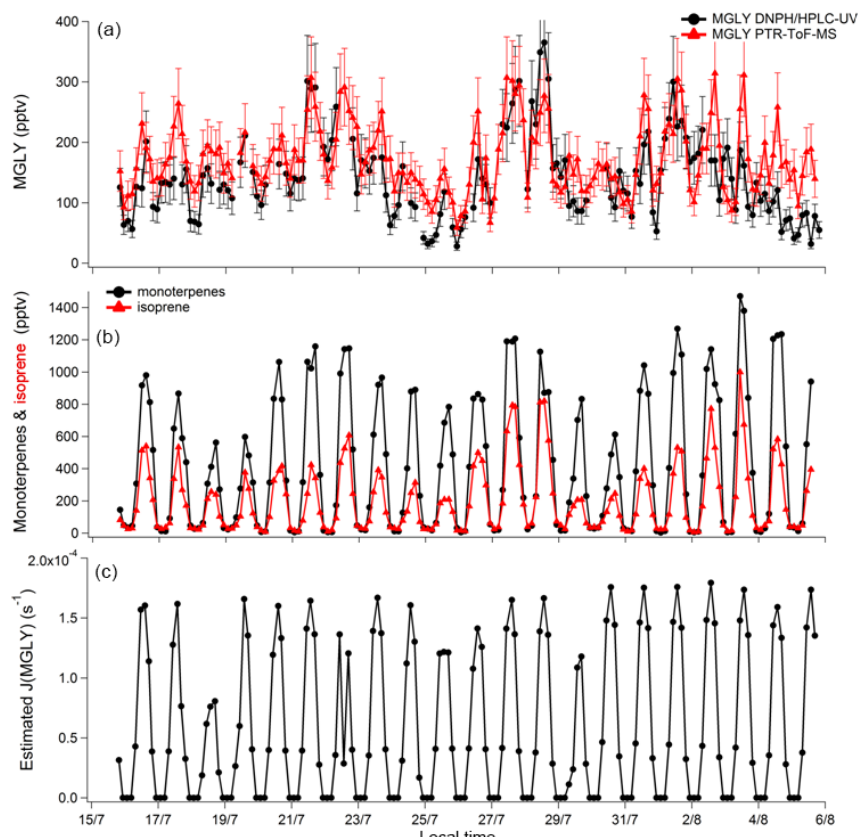
Figure 2. Time series of MGLY measured by PTR-ToF-MS (red) and active sampling on DNPH cartridges (black) (a) ; sum of monoterpenes (black) and isoprene (red) measured by PTR-ToF-MS (b) ; and estimated J ( MGLY ) (black) (c) . Error bars for MGLY measurements (a) correspond to systematic errors of 22% and 25% for PTR-ToF-MS and DNPH cartridge measurements,